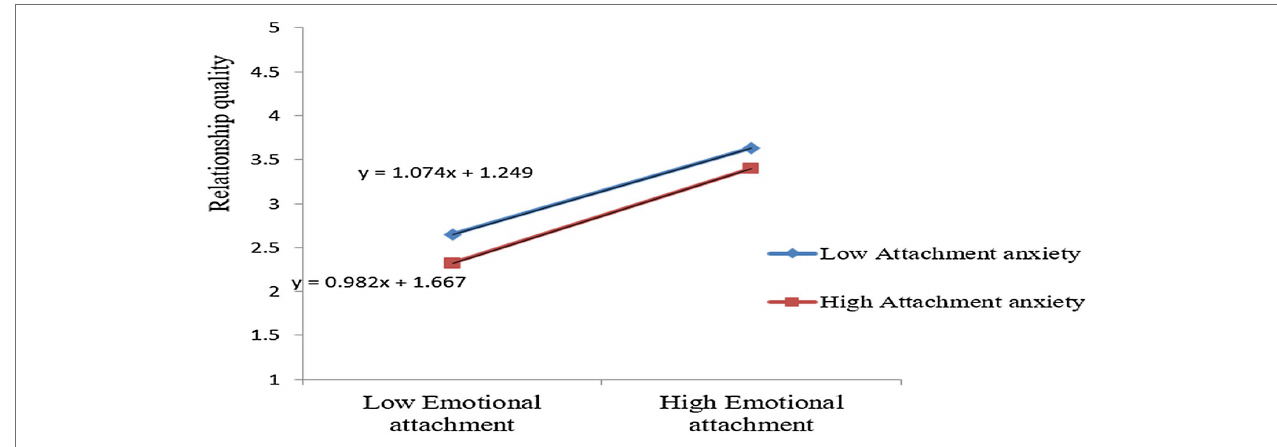
FIGURE 2 | Attachment anxiety (AA) moderating the relationship between emotional attachment (EA) and relationship quality